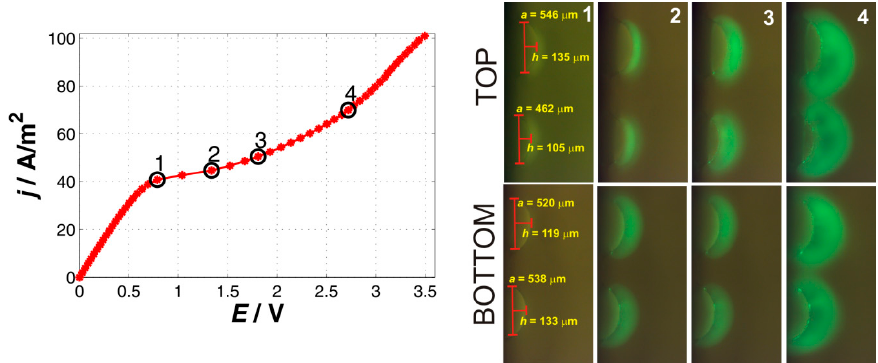
Figure 4. Current–voltage curve and a set of characteristic images for the four-particle membrane. The black circles on the current-voltage curve mark the current densities at which the depicted fluorescent images denoted as 1, 2, 3, and 4 were obtained.